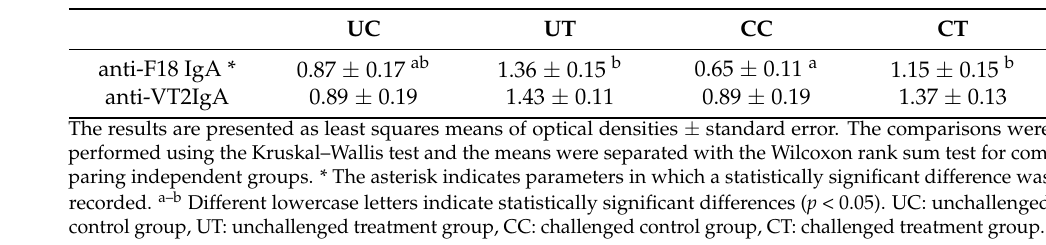
Table 4. Titer of specific anti-F18 and anti-VT2 IgAs in faecal samples.